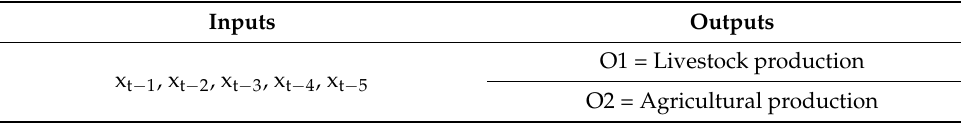
Table 1. The prepared dataset for time-series prediction.